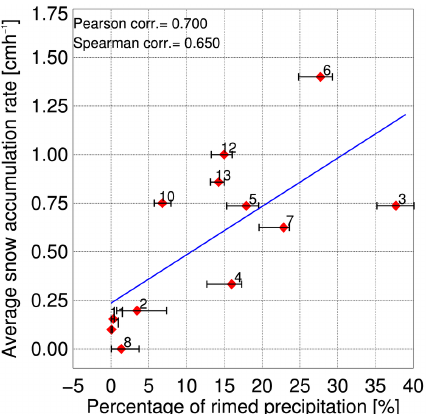
Figure 2. Relation between the percentage of rimed precipitation (PRP, retrieved by means of radar data) and mean snowfall accumu- lation rate, for the events listed in Table 1. The error bars represent the 5 and 95% quantiles of PRP values calculated for maximum altitudes z 2 (in Eq. 1) varying between 2250 and 4000m. A linear regression line is displayed in blue.